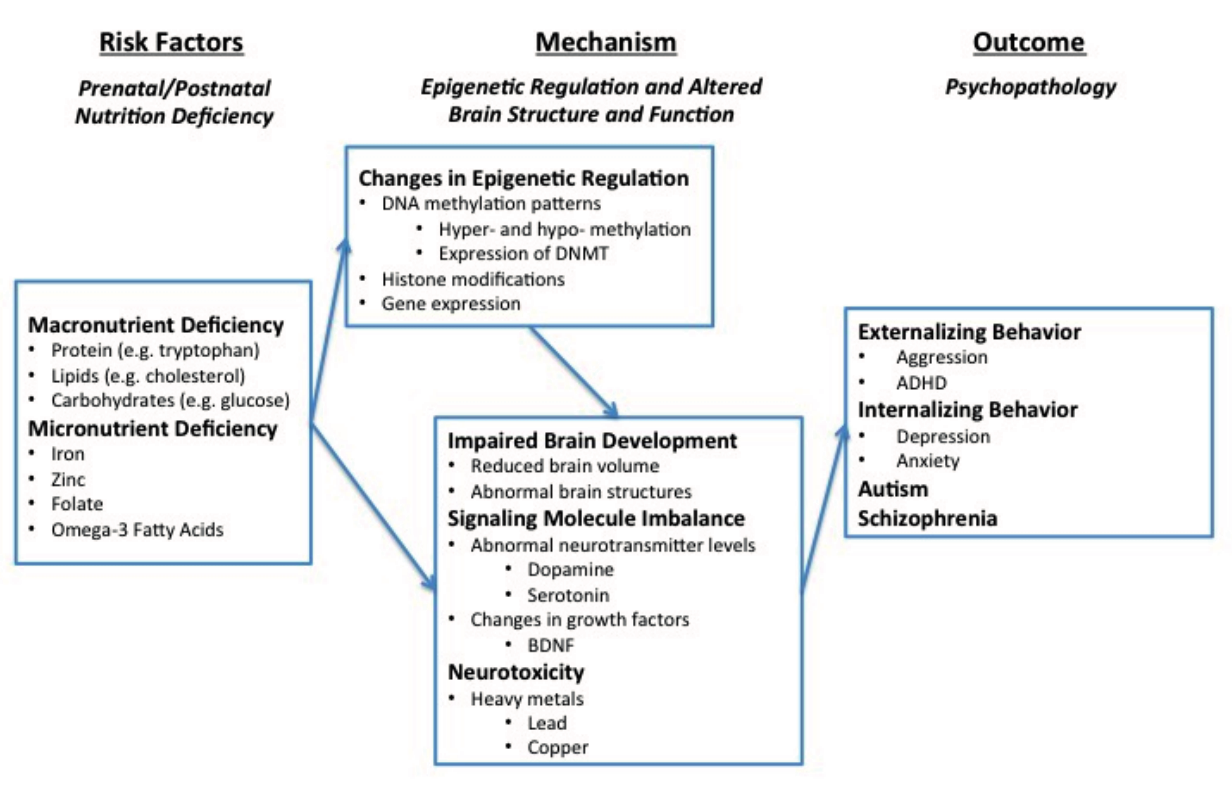
Figure 1. Conceptual Framework of Epigenetic and Altered Brain Structure as Mechanisms of